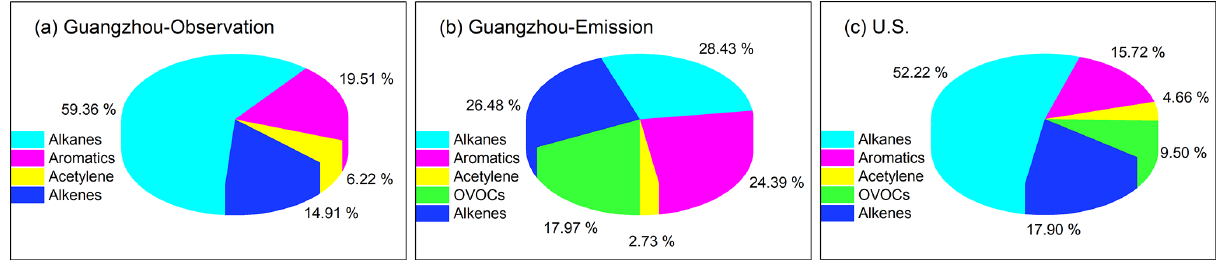
Figure 1. VOC compositions (ppbvppbv − 1 ) in (a) observation-based inputs of Guangzhou scenarios, (b) emission-based inputs of Guangzhou scenarios, and (c) US scenarios. The US scenario data are taken from Carter